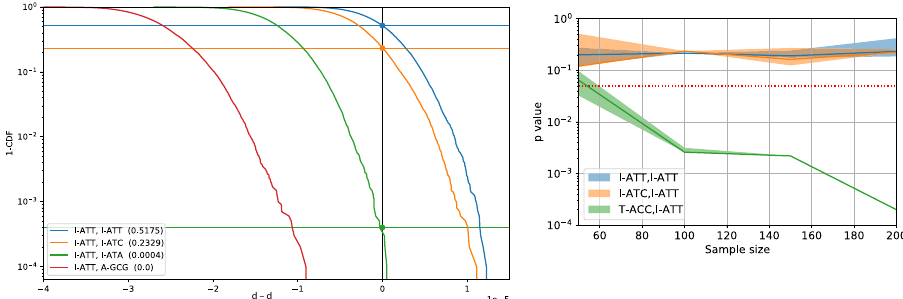
Fig. 7 Example of test statistic distribution in the permutation test. Left: Codon pairs are compared using the L 1 distance statistic between their dihedral angle KDEs in the β -sheet secondary structure mode. For each pair, depicted is one minus the cumulative distribution function (1-CDF) of the difference between the L 1 distance between the pair of KDEs and one between the pair of KDEs constructed with permuted labels. The intersection of 1-CDF with the vertical axis yields the p-value of the one-sided test (null hypothesis: d-d perm ≥ 0). When comparing a codon to itself (I-ATT, I-ATT), the null hypothesis holds, and the difference is expected to be positive half of the times ( p -value ≈ 0.5). The indistinguishable pair I-ATT, I-ATC produces a high p -value, while the more clearly distinguishable pair I-ATT, I-ATA yield a very low p -value. Two non-synonymous codons (I-ATT, A-GCG) appear perfectly distinguishable. Distributions were calculated using 100 bootstrap samples with 200 permutations in each. Right: p -values of pairwise comparison of a full sample of I-ATT in the β -mode (1365 samples) vs. different sample sizes of I-ATC and T-ACC ( N = 50, 100, 150, and 200). The p-value of the distinguishable T-ACC, I-ATT pair decreases with the growth of the sample size. Con fi dence intervals are 20%- and 80%-percentiles calculated on 10 random